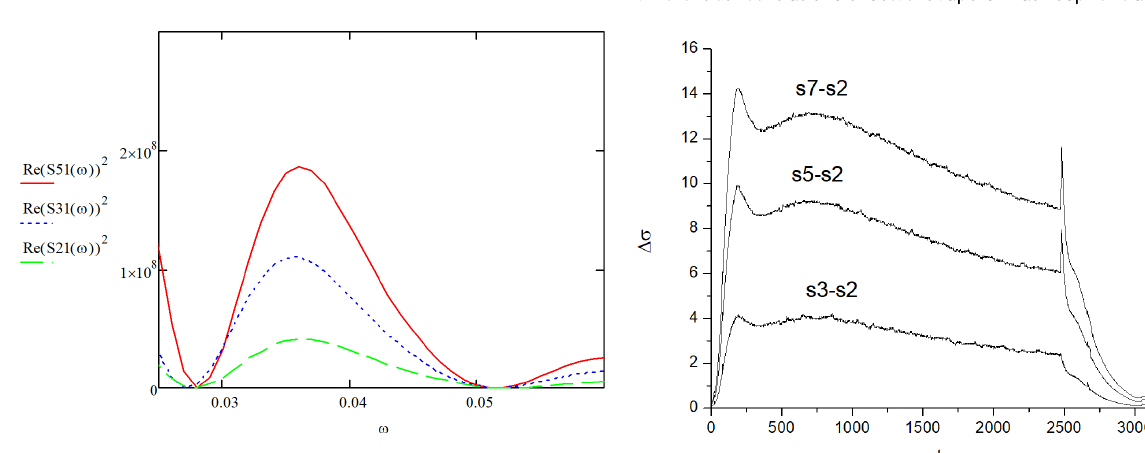
Figure 5. The first time derivatives of the Fourier-images for three different concentrations of gasoline.